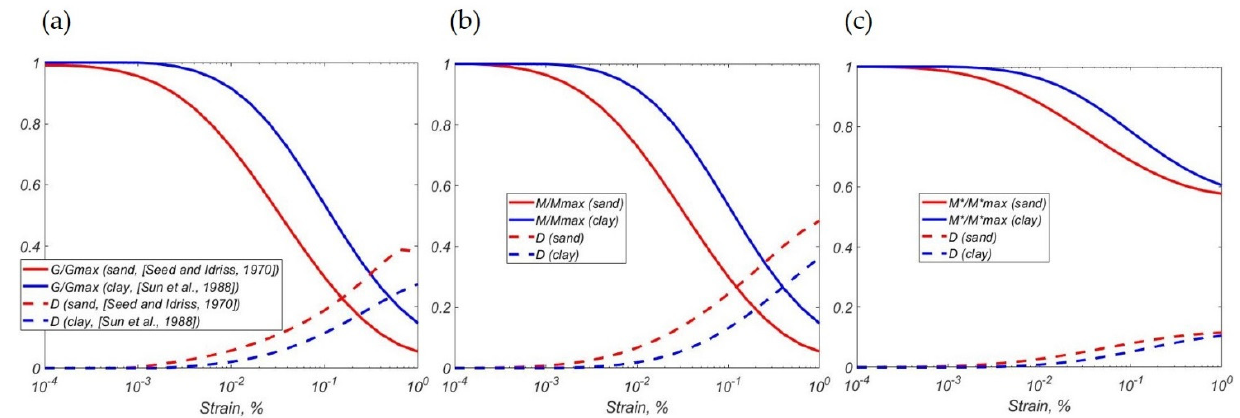
Figure 8. Degradation curves of shear modulus G/G max ( γ ) ( a ), constrained moduli above water table M/M max ( γ ) ( b ) and under water table M*/M* max ( γ ) ( c ) and corresponding damping ratio curves D ( γ ) ( c ) used for modeling the responses for TCGH15 and KSRH10 Kik-net sites. Table 1. Geotechnical parameters (initial and calculated) at the TCGH15 sandy site of the Kik- net network.